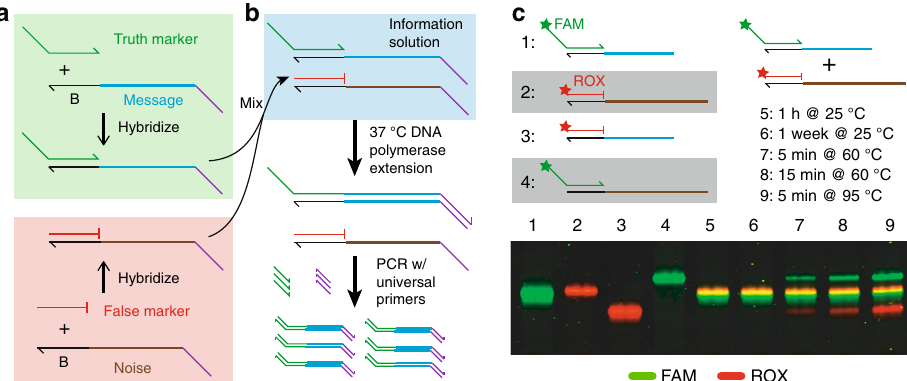
Fig. 2 Metastable hybridization-based DNA information encoding. a Preparing encoded messages. DNA oligos encoding the intended messages (cyan) are hybridized with truth marker oligos (green). In a separate solution, DNA oligos encoding noise messages (brown) are hybridized with false marker oligos (red). The two solutions are then mixed to form the information solution. b Reading the information solution. DNA polymerase and dNTPs are added to information solution, and the truth markers are extended to copy the intended messages. The false markers (red) have a three C3 functionalization and are unable to be extended. The mixture of extended truth markers is then ampli fi ed by PCR to generate a library encoding the true messages, which can then be read by NGS. c Experimental characterization of truth marker binding stability via polyacrylamide gel electrophoresis. Shown in the bottom panel is a composite of two images of the same gel scanned using different fl uorescence fi lter sets, with the FAM image false colored in green, and the ROX image false colored in red. Lanes 1 and 2 show the intended message prehybridized to the truth marker and the noise DNA prehybridized to the false marker, respectively. Lanes 3 and 4 show the intended message prehybridized to the false marker and the noise DNA prehybridized to the truth marker. Lanes 5 – 9 show the mixture of the species in Lanes 1 and 2 incubated for different amounts of time at different temperatures. See Supplementary Note 2 for further analysis